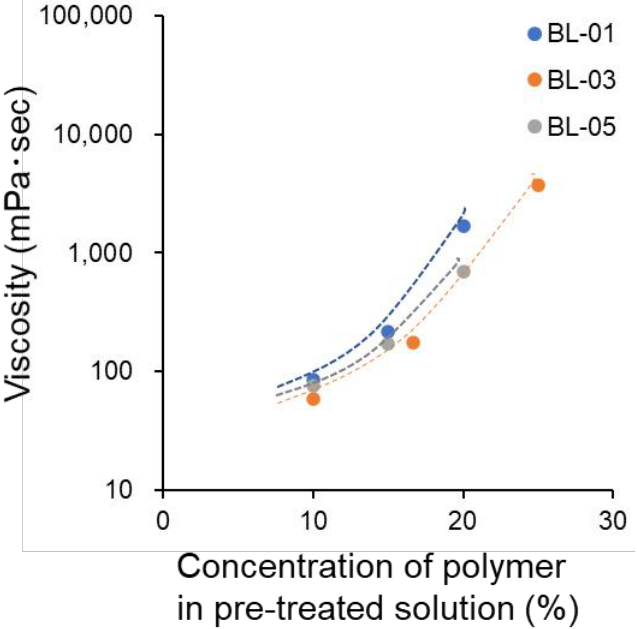
Figure 6. Viscosity of pre-treated solution of BL-01, BL-03 and BL-05 using EMS viscometer.